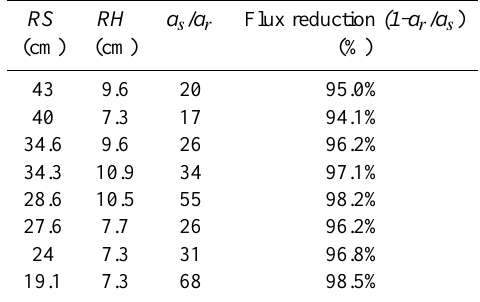
Table 6. Flux reduction due to geometric characteristic of ridges.